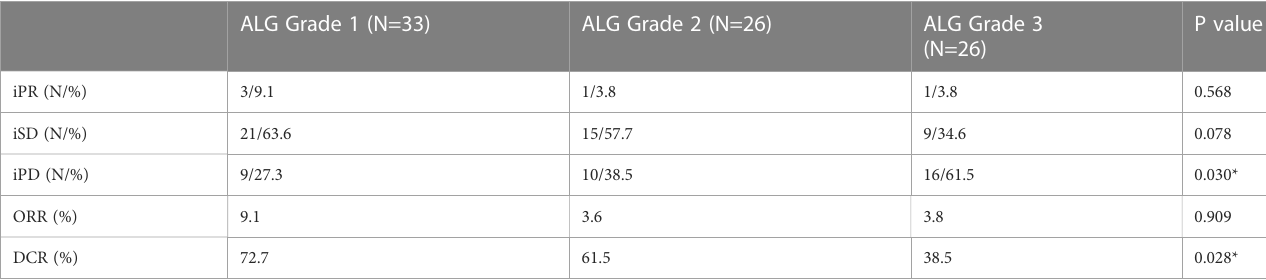
TABLE 2 Tumor response of patients with different grade of ALG.